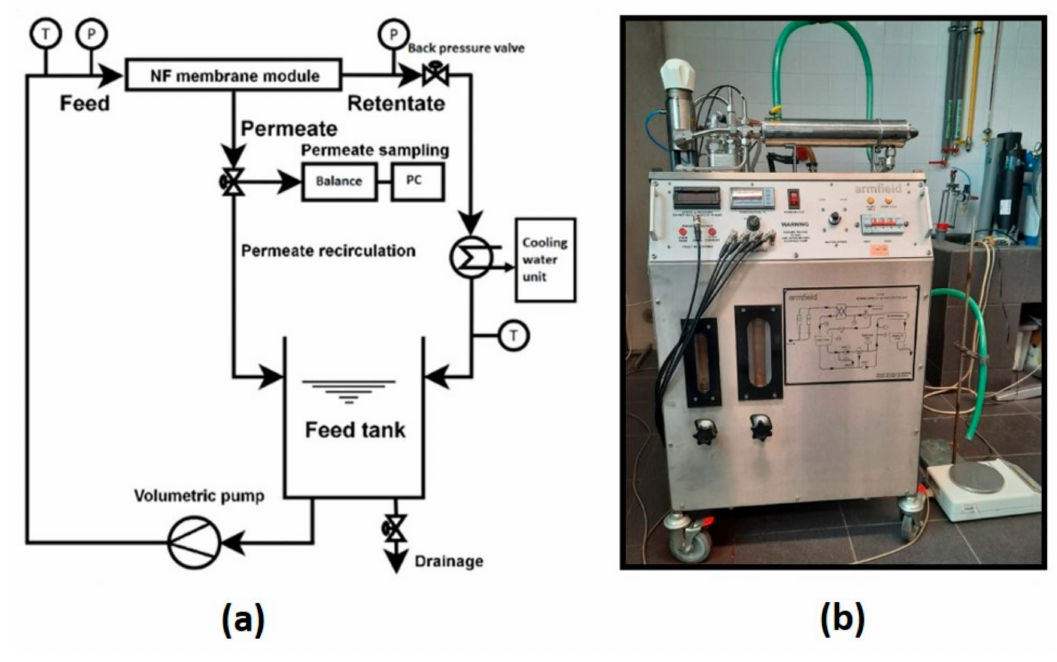
Figure 1. Experimental setup of the nanofiltration unit ( a ) diagram and ( b ) actual NF lab unit. Table 2. HPLC parameters for caffeine, paracetamol and